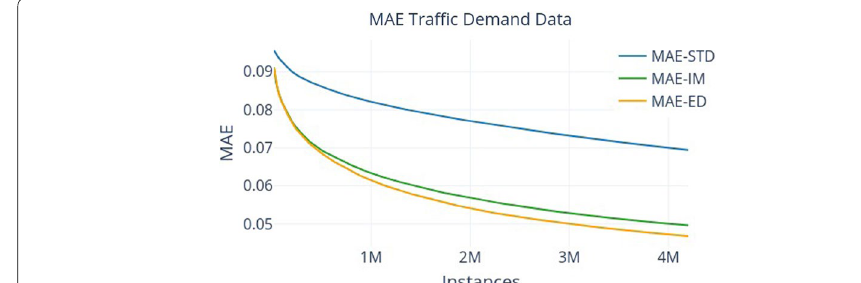
Fig. 2 MAE comparison of the traffic demand data